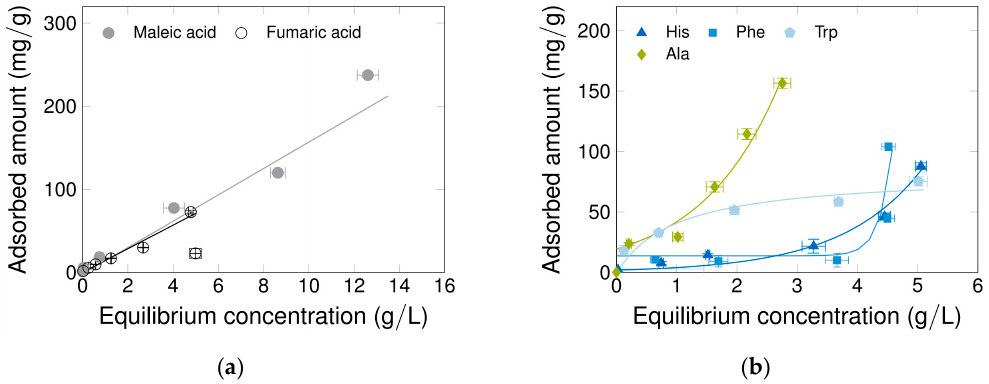
Figure 2. Static binding capacities of ( a ) two carbon acids isomers at pH = 7 and ( b ) four amino acids at pI (neutral charged). The adsorbed amount is related to the dry mass of CNT-K. The experiment was performed at RT, 24 h, 500 rpm, with 2 or 3 technical replicates, triple determination at 216 or 280